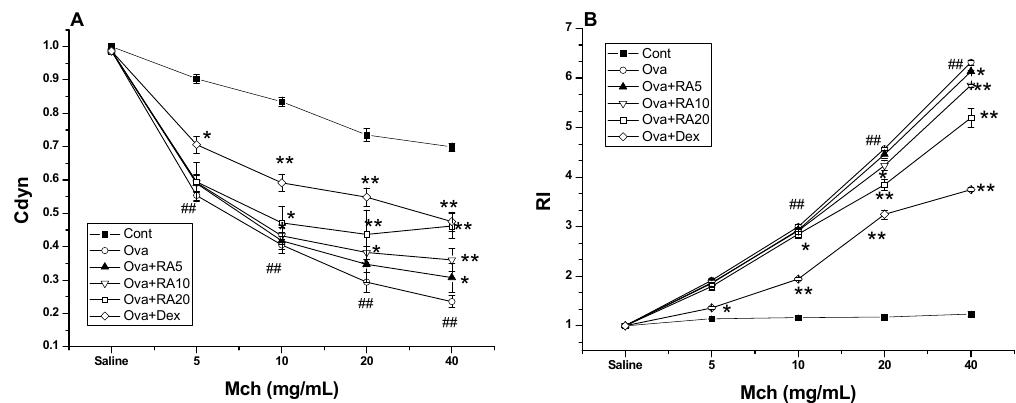
Figure 4. Effects of RA on Ova-induced AHR in the mice. The reduction in dynamic compliance (Cdyn) in response to methacholine ( A ) and the increase in lung resistance (RI) in response to methacholine ( B ) were assessed by the changes relative to the basal values in response to saline. # p < 0.05, ## p < 0.01 vs. control group; and * p < 0.05, ** p < 0.01 vs. Ova.